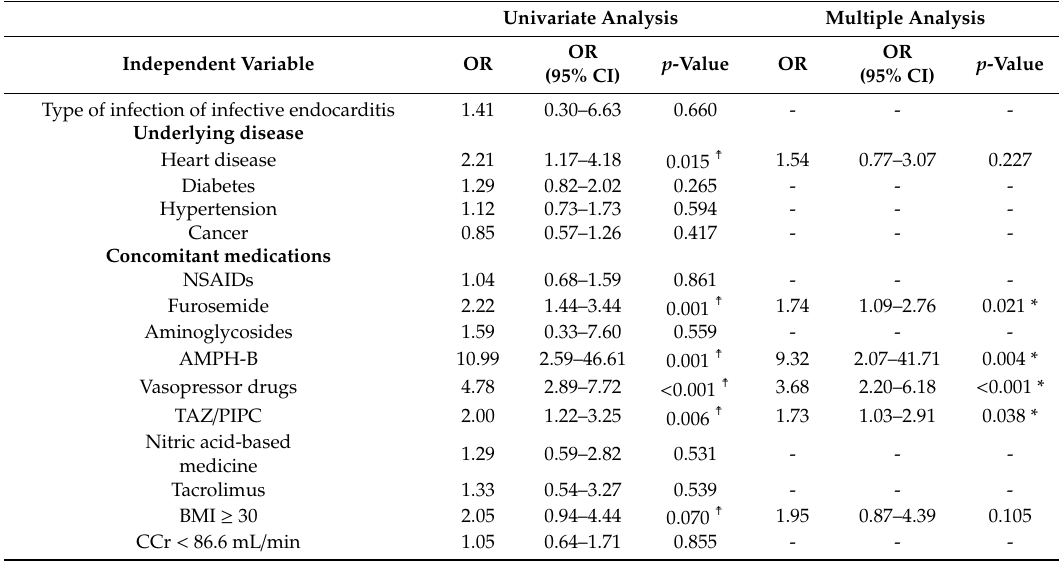
Table 2. Logistic regression analysis (dependent variable: AKI).